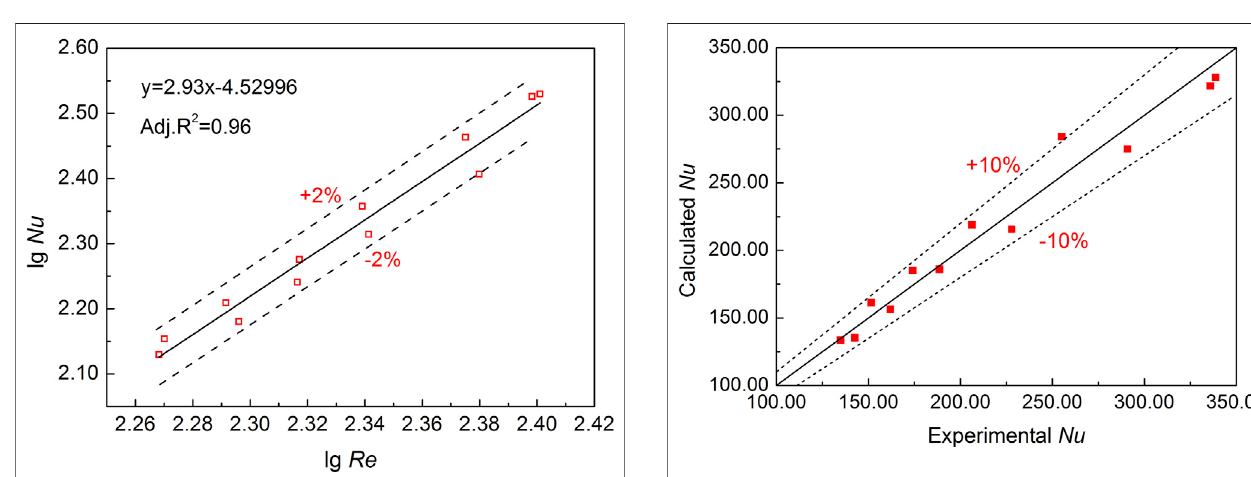
FIGURE 4 | Reynolds and Nusselt numbers logarithmic fi tting relation.